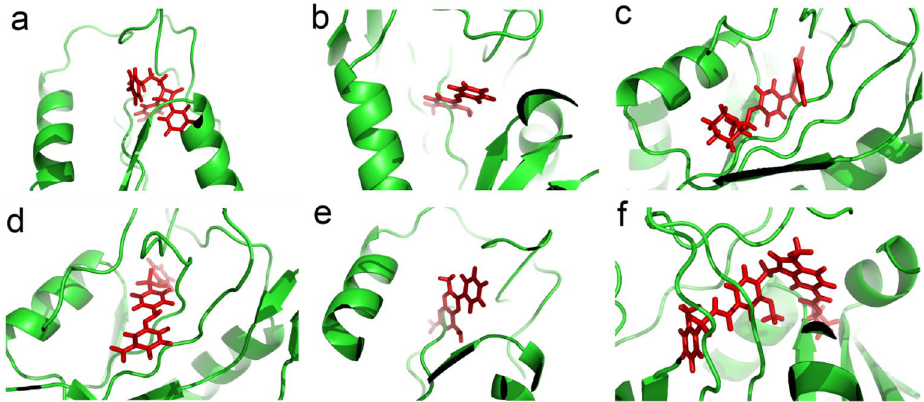
Figure 1. The best drugs with high affinity bind in the groove of the TgDHFR. ( a ) Ezetimibe, ( b ) Phenazopyridine, ( c ) Raloxifene, ( d ) Sulfasalazine, ( e ) Triamterene, ( f ) Zafirlukast. The figures are created by using PyMOL Version